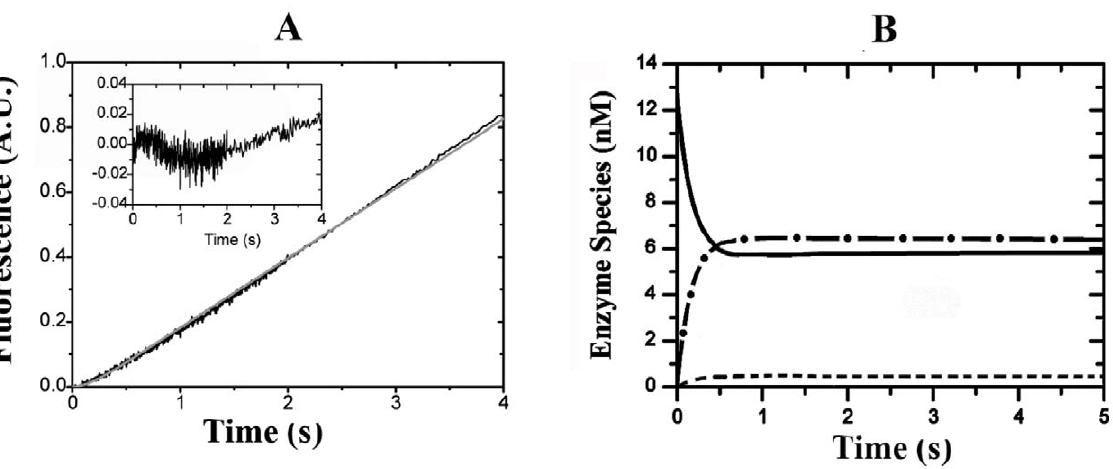
Figure 4. Stopped-flow time-traces of FRET-peptidehydrolysis by HNE in the presence of heparin. A , the stopped-Flow fluorescence kinetic recording of 3.8 m MFRET-peptide hydrolysis by 12.6 nM HNEperformed at 25 u C in 10 mM Tris-HCl buffer, pH 7.4, containing 100 mM NaCl supplemented with 50 m M heparin. The progress of the reaction was monitored by the fluorescence increase of the released product recorded on two adjacent time regions with distinct sampling periods: 0.5 ms from 0 to 2 s, 2 ms from 2 to 4 s. Gray solid line represents the best fit deduced from the mechanism depicted in Scheme I in the presence of heparin using DynaFit IV H Software [see Experimental Procedures]. The insert graphic represents the associate residual errors from the best fit curve with experimental data. B , the HNE species in function of time reaction in presence of